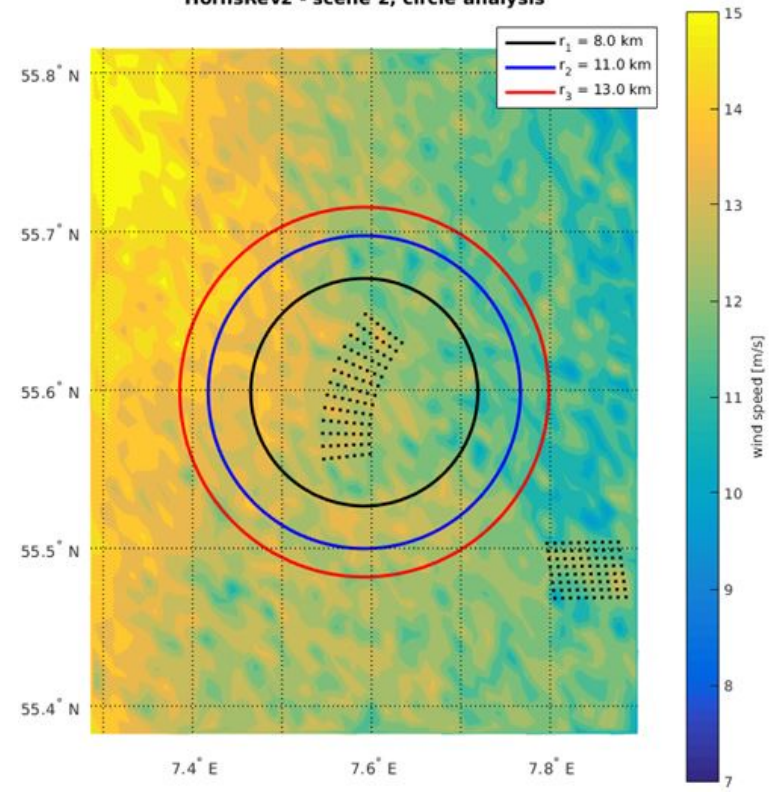
Figure 6. Example of the circles centered on Horn Rev 2 wind farm. The radii are 8, 11 and 3